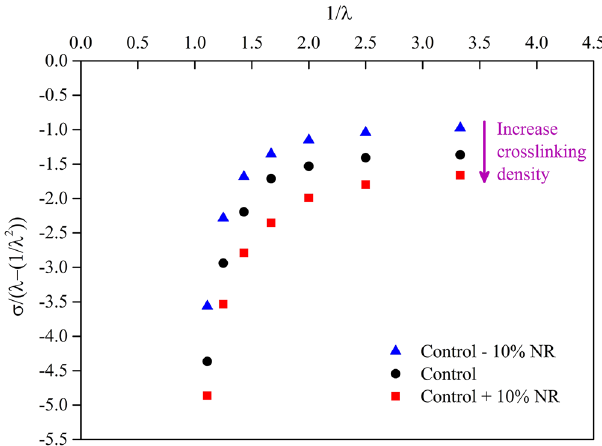
Figure 4. The relationship of stress, σ, and compression limit, λ, of foam samples based on the Mooney–Rivlin Eq. 26 . The relative scatter on the results is estimated equal to about 5%.